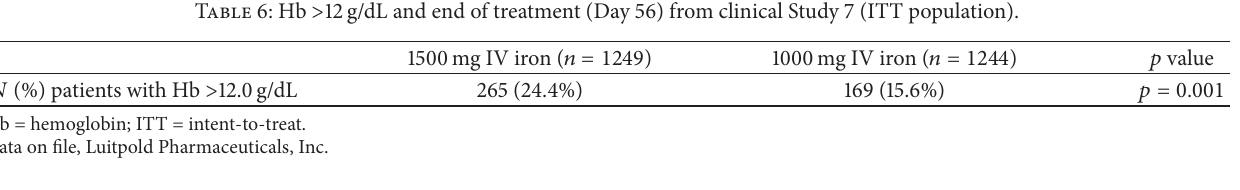
Table 7: Subjects with Hb > 11g/dL, 12g/dL, or Hb change ≥ 1g/dL in Study 7 anytime from randomization to end of study (Safety Population).